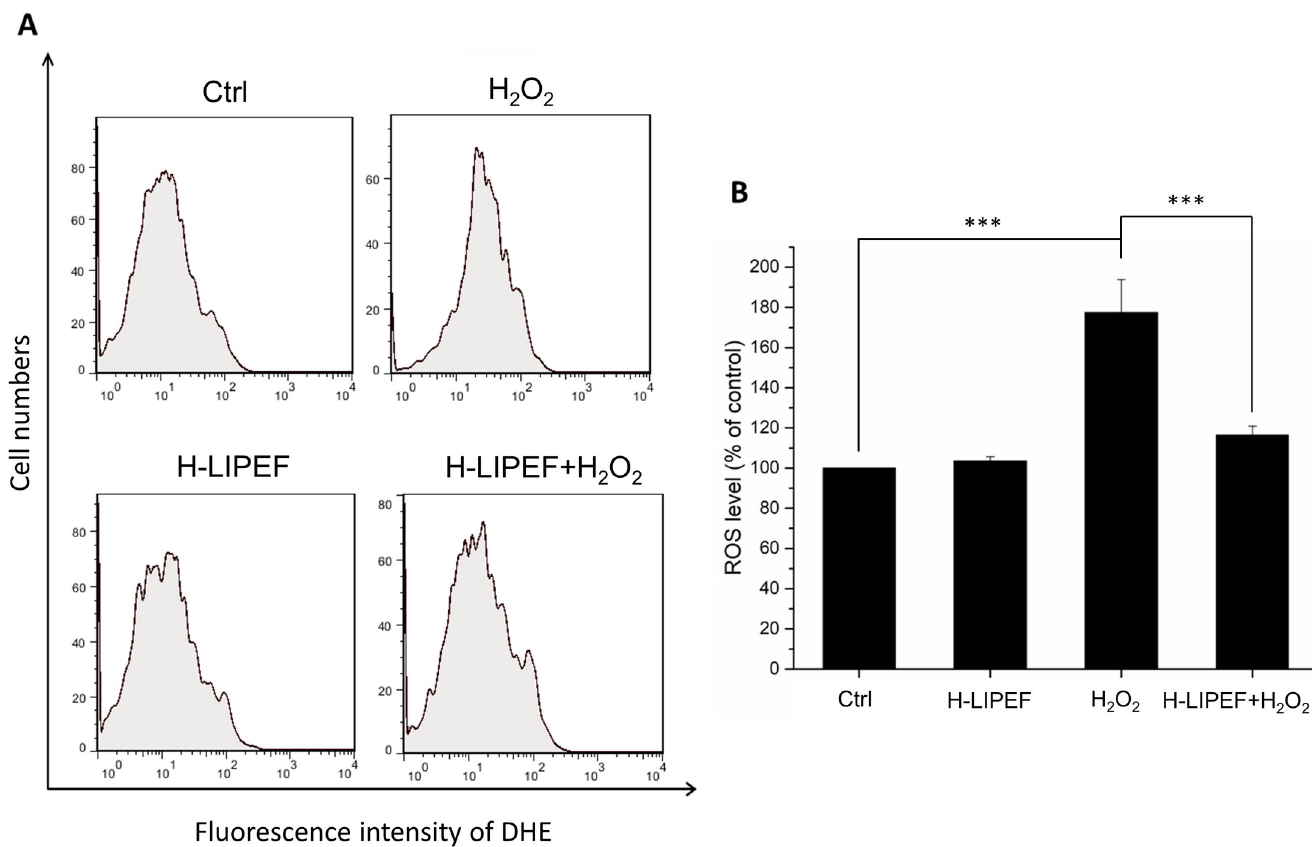
Fig 6. Effect of H-LIPEF on H 2 O 2 -induced ROS generation in SH-SY5Y cells. (A) ROS level was measured by flow cytometry with DHE fluorescent dye. (B) Quantification of the ROS levels after H-LIPEF, H 2 O 2 , or H-LIPEF+H 2 O 2 treatment. Data represent the mean ± standard deviation (n = 3). Comparisons of the effect of H 2 O 2 and H-LIPEF on the ROS generation were analyzed using two-way ANOVA with Tukey’s post hoc test ( ��� P < 0.001).